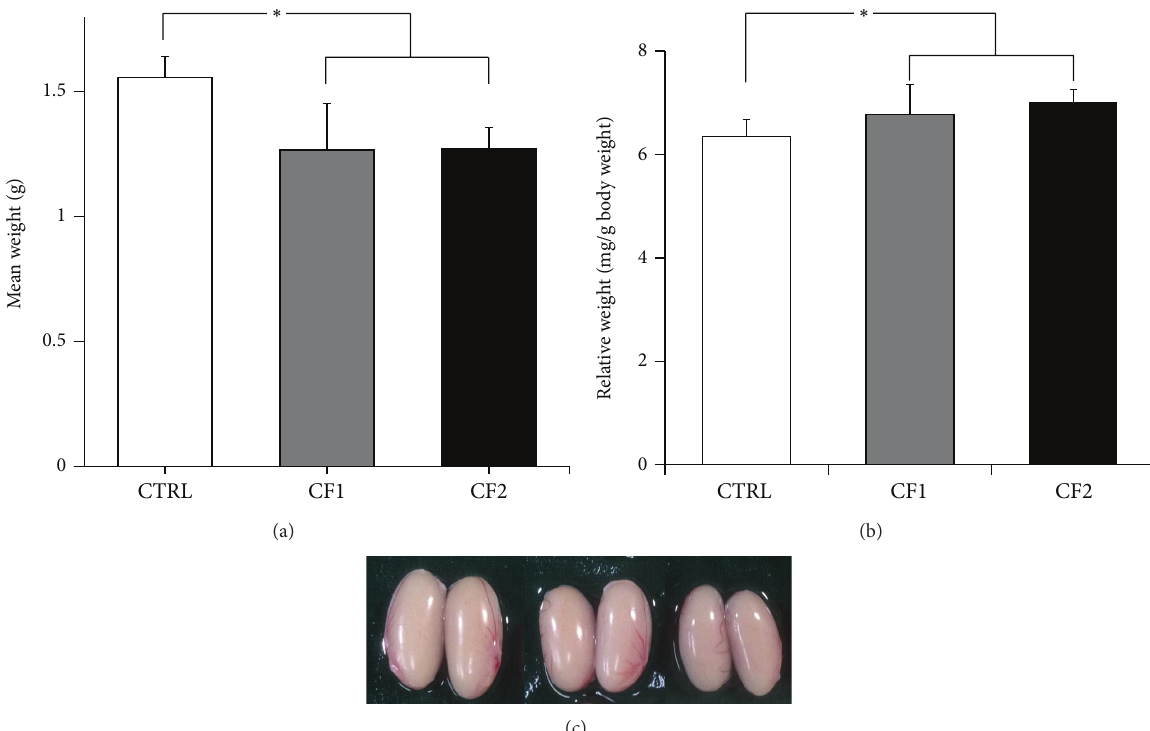
Figure 3: Effect of caffeine on the weights of the testes in the control and caffeine-fed animals. (a) Absolute testes weight (g) and (b) relative testis weight to body weight (mg/g body weight) in the control and caffeine-fed groups at 4 weeks of caffeine exposure. Values are expressed as mean ± SD. ∗ 𝑝 < 0.001 versus CTRL. (c) Representative picture of the testes. From the left in order, testes representing each group are designated as CTRL, CF1, and CF2. CTRL, control; CF1, caffeine 120mg/kg/day; CF2, caffeine 180